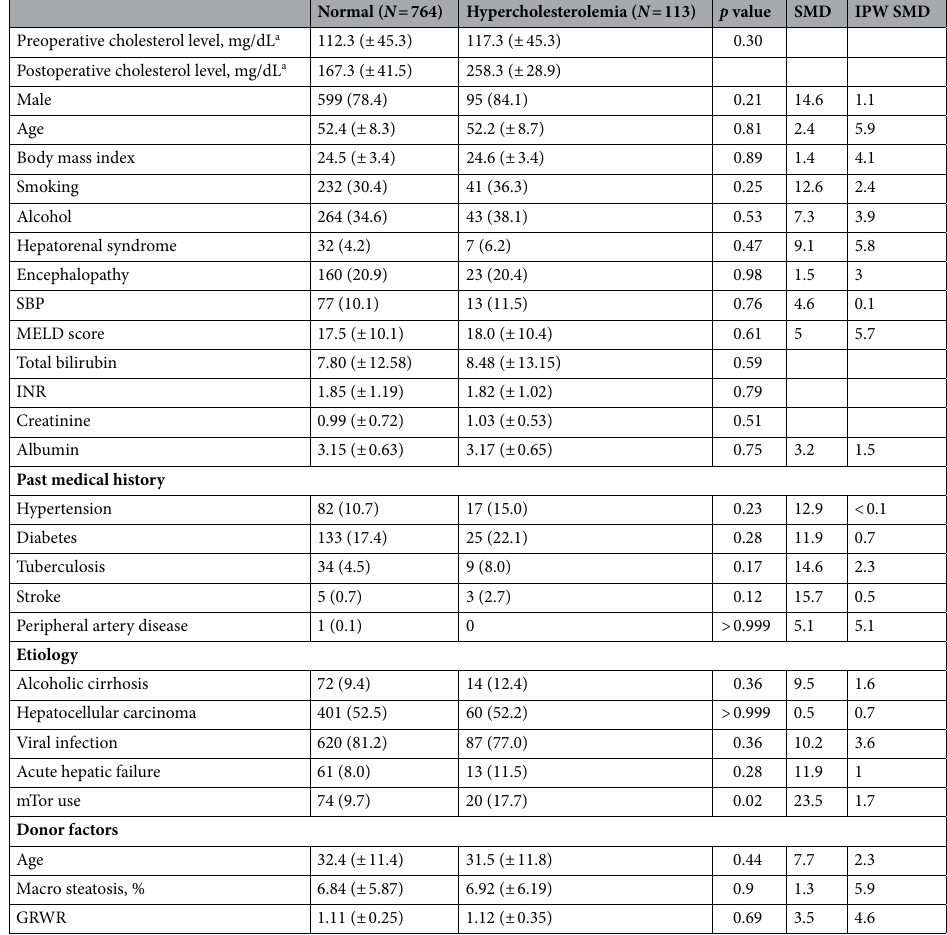
Table 1. Baseline characteristics. SBP spontaneous bacterial peritonitis, MELD model for end-stage liver disease, INR international normalized ratio, GRWR graft-to-recipient weight ratio. a Pre- and postoperative cholesterol levels were not retained in the statistical